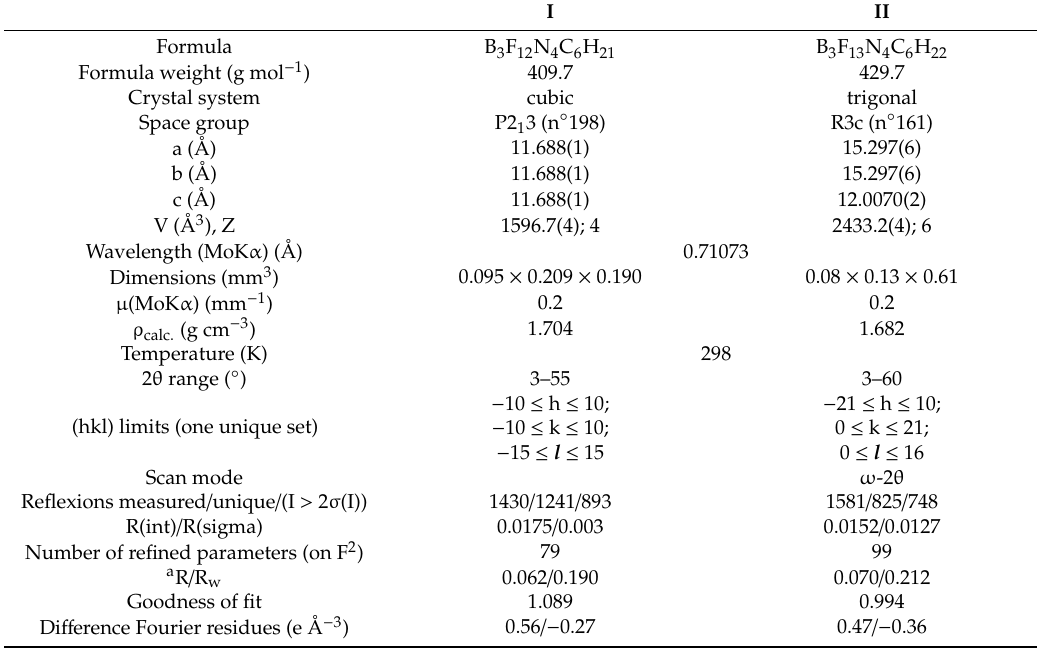
Table 1. Crystallographic data of [H 3 tren ](BF 4 ) 3 (I) and [H 3 tren ](BF 4 ) 3 HF